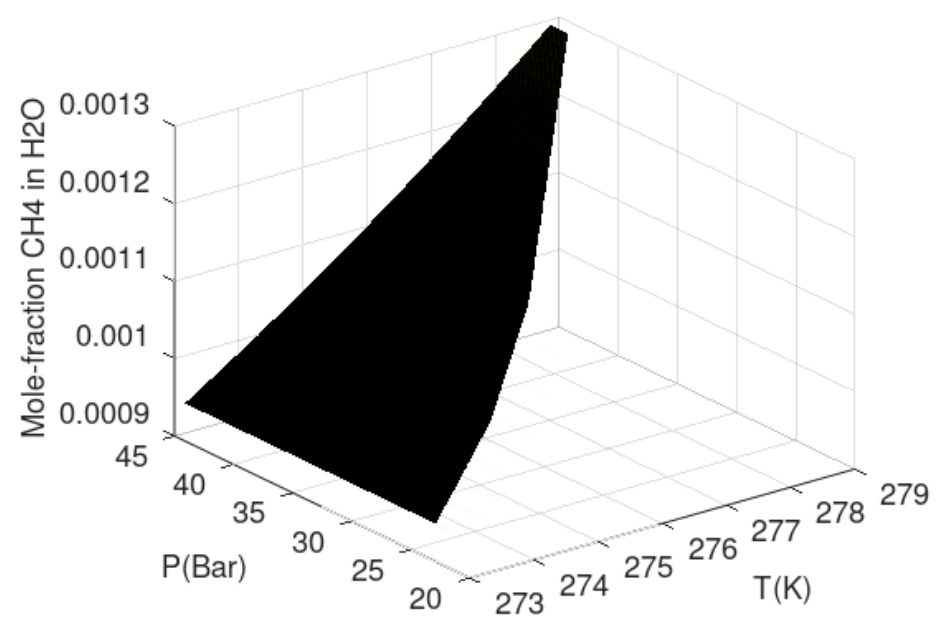
Figure 4. Hydrate stability limits in terms of minimum methane mole-fractions in surrounding water needed to keep methane hydrate stable.